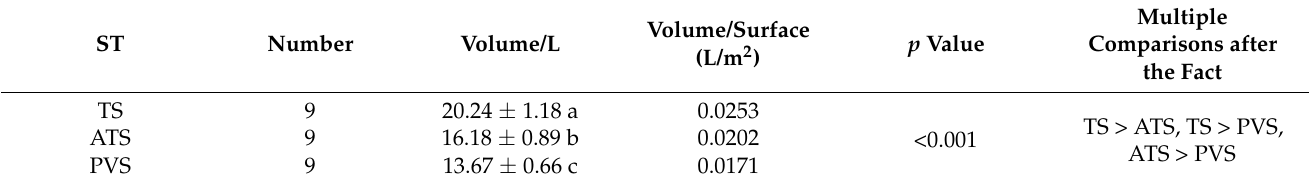
Table 3. Results of ANONA analysis of spraying volume. Volume/Surface (L/m 2 ) was based on pesticide application and leaf wall area (800 m 2 ) of test tree rows. The data in the table were obtained through SPSS. SEM was used to represent the deviation of the data in the table.